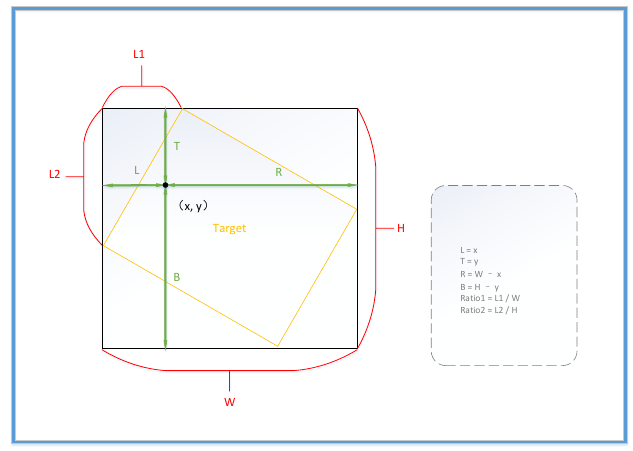
Figure 2. The annotation form we defined of target’s RBox.